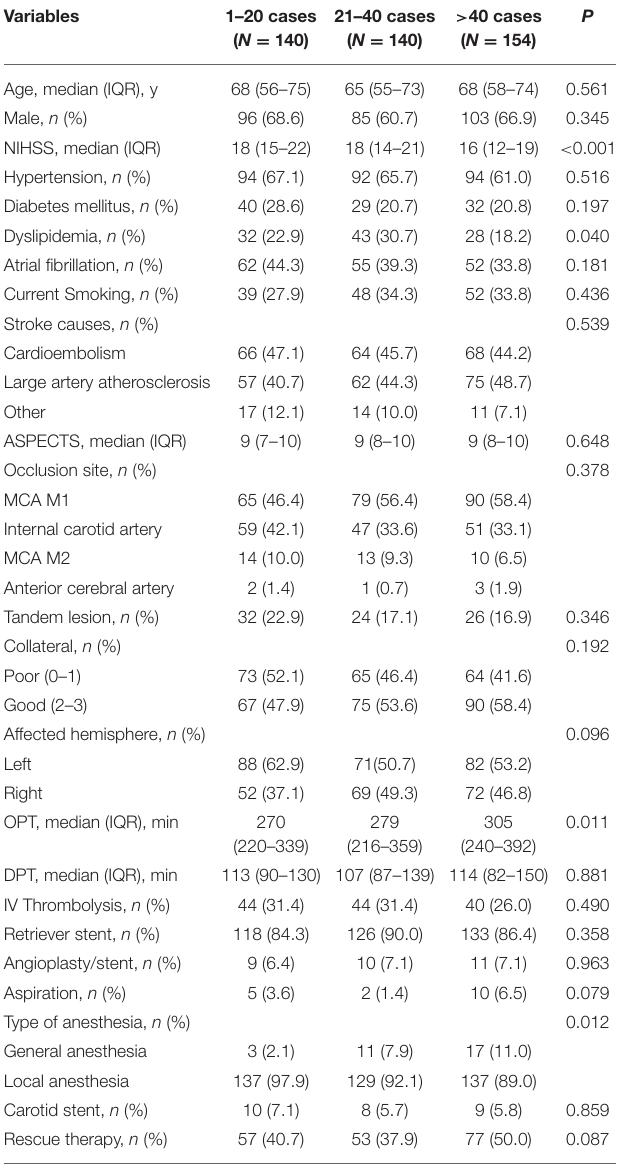
TABLE 1 | Patient-related and treatment-related variables according to procedural experience